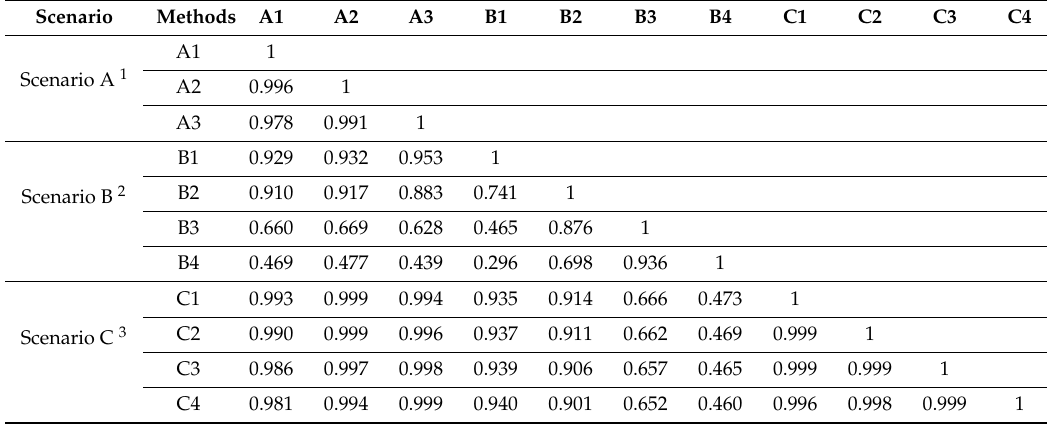
Table 6. The results of Spearman correlation analysis between Mahalanobis distances (MDs) of 3028 chemicals using di ff erent quantification